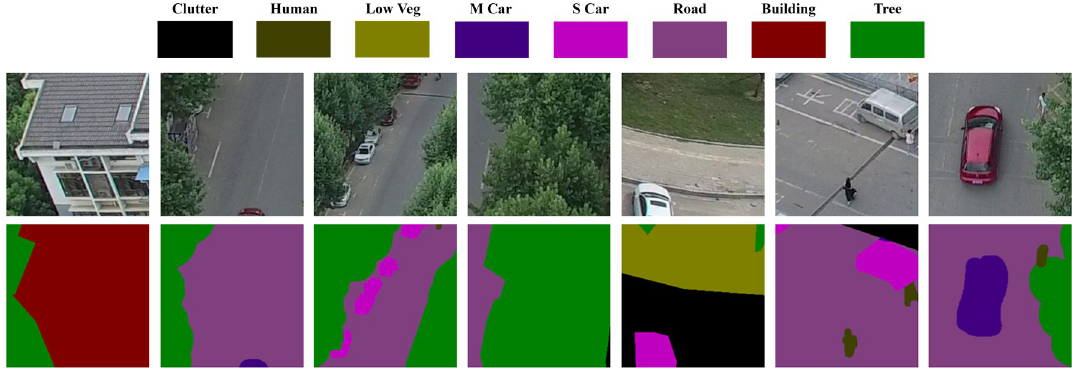
Fig 4. UAVid dataset example. Reprinted from [16] under a CC BY license, with permission from [UAVid], original copyright [2020].